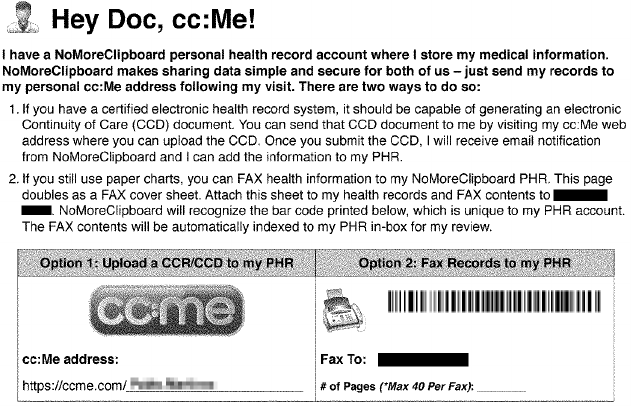
Figure 11. Cc:me feature in